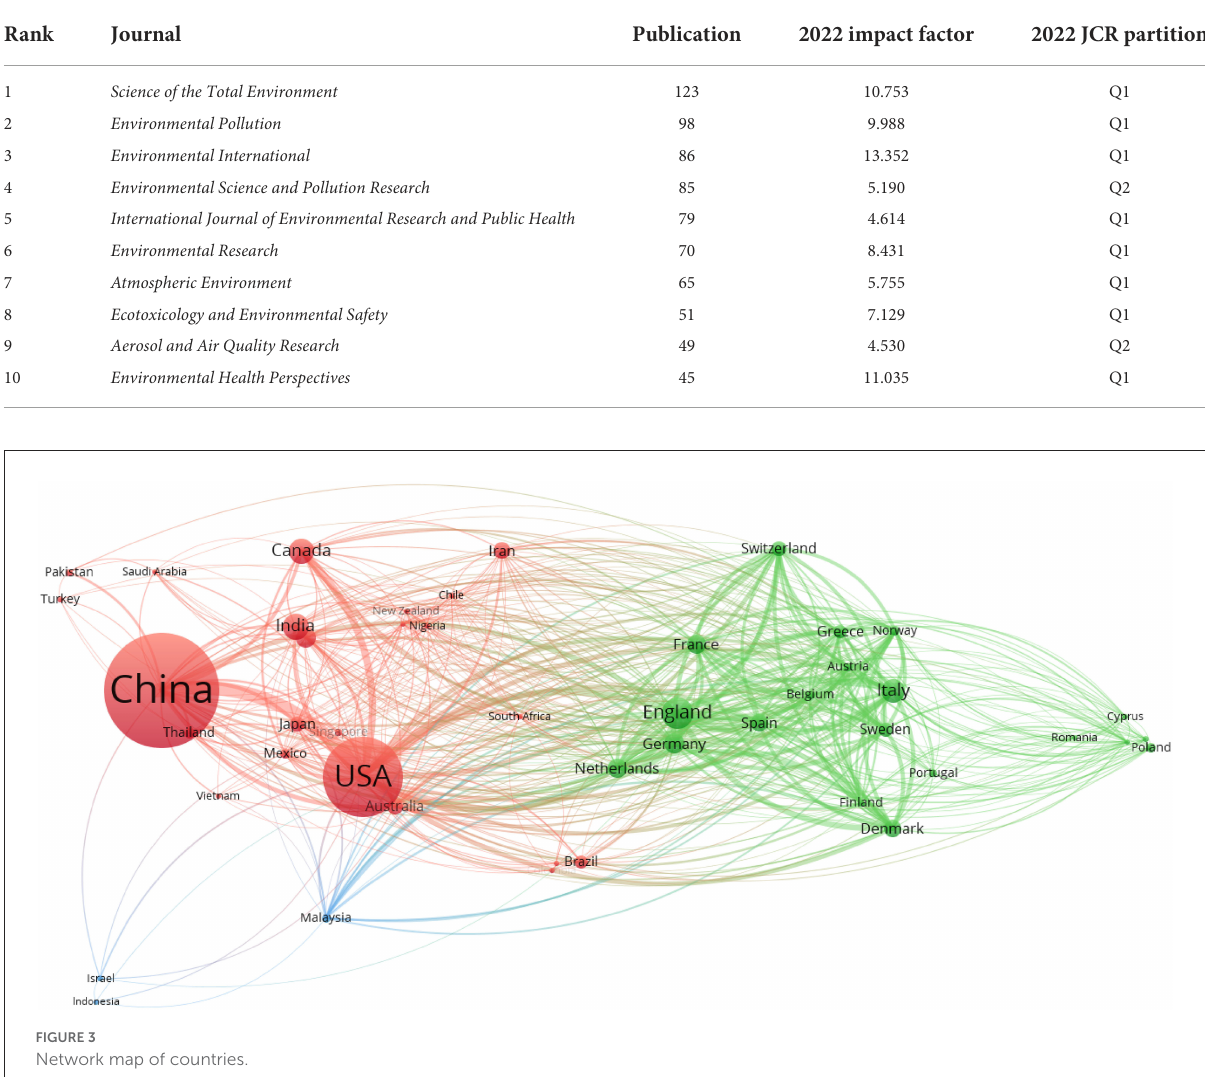
TABLE 1 Top 10 productive journals with IF and JCR partition.